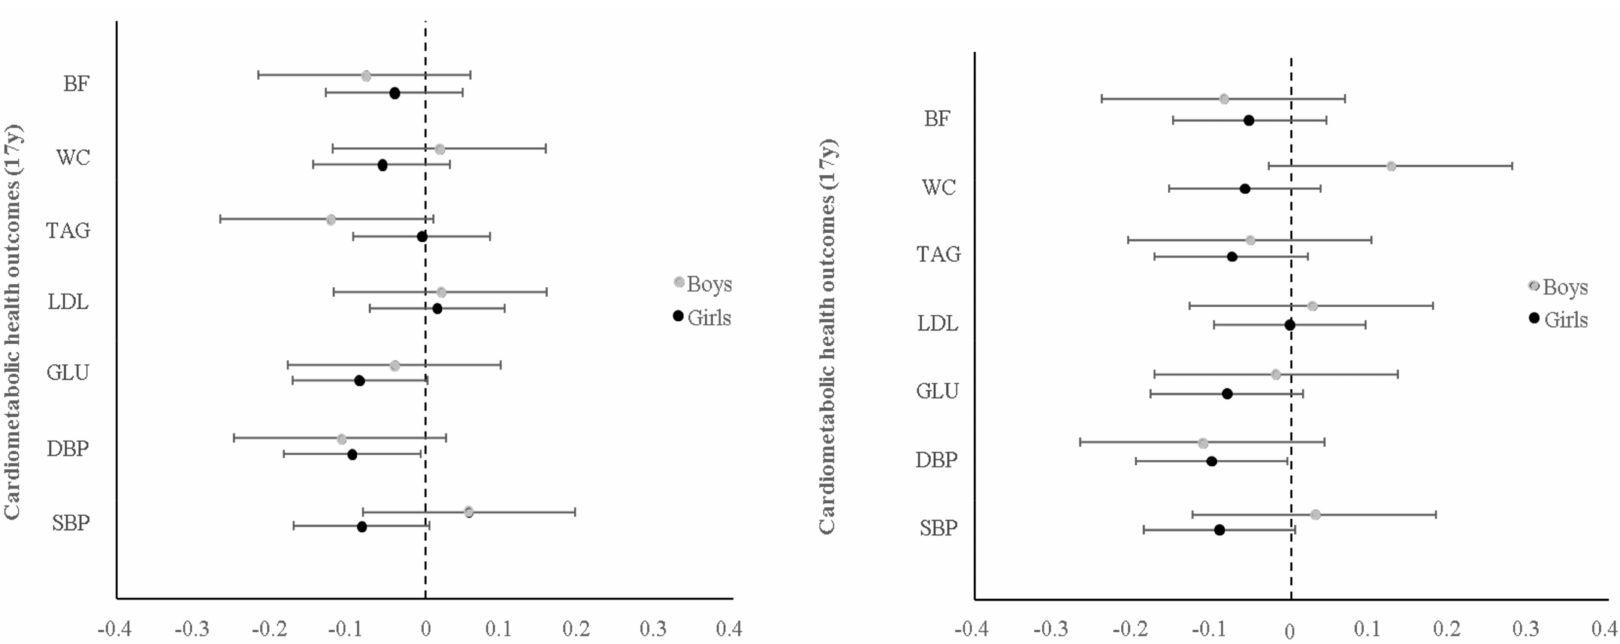
Figure 3. Associations between PA pattern score trajectories (13 years–17 years) and cardiometabolic health outcomes at 17 years in boys and